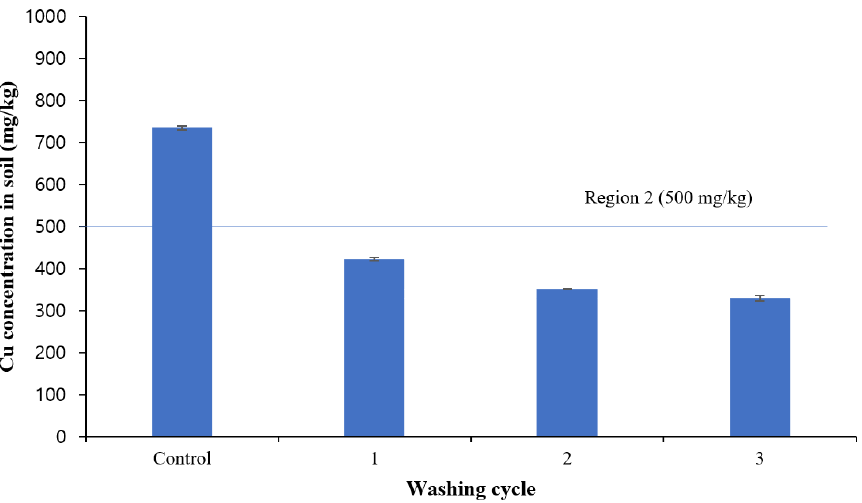
Figure 9. Cu concentrations remaining in the soil after 1, 2 and 3 high-pressure washing cycles.